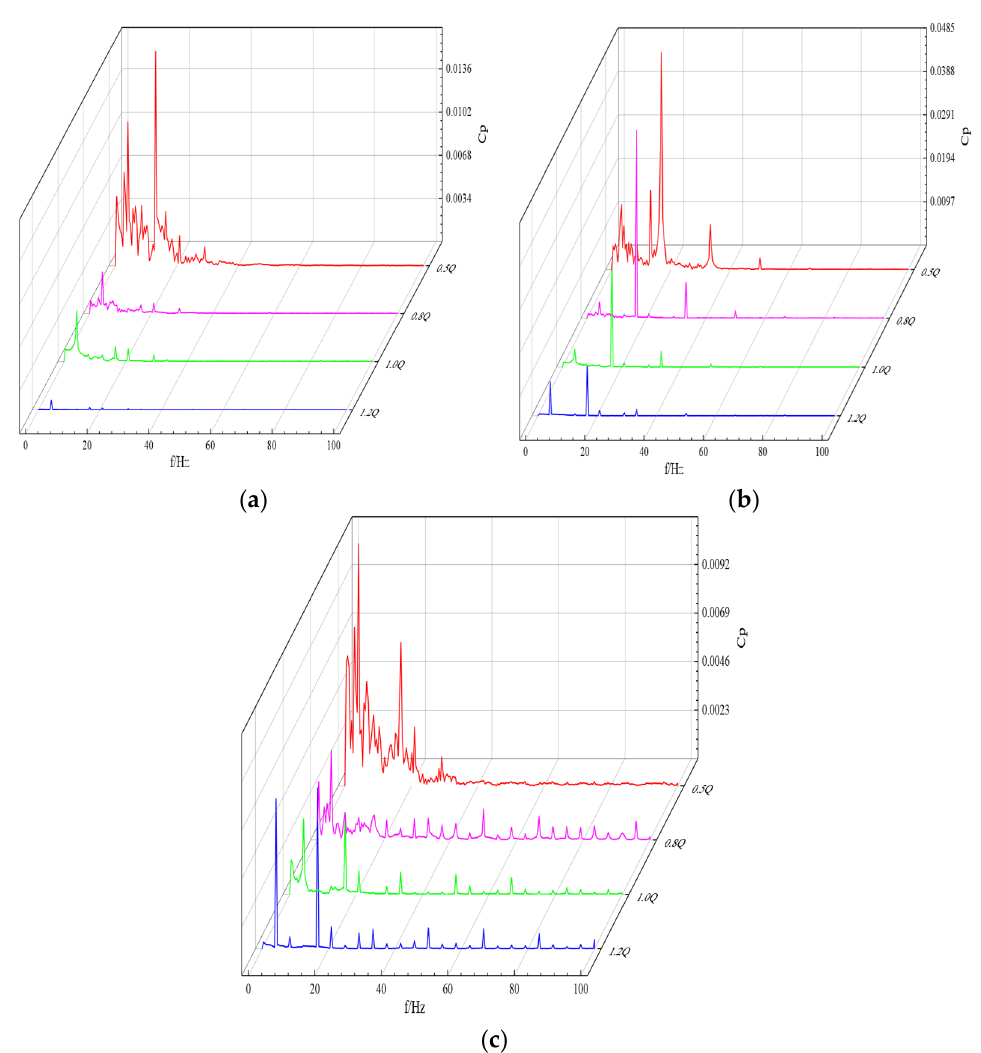
Figure 10. Frequency domain distribution of pressure pulsation in pump working conditions. ( a ) Monitoring point a3 ( b ) Monitoring point b3. ( c ) Monitoring point c3.